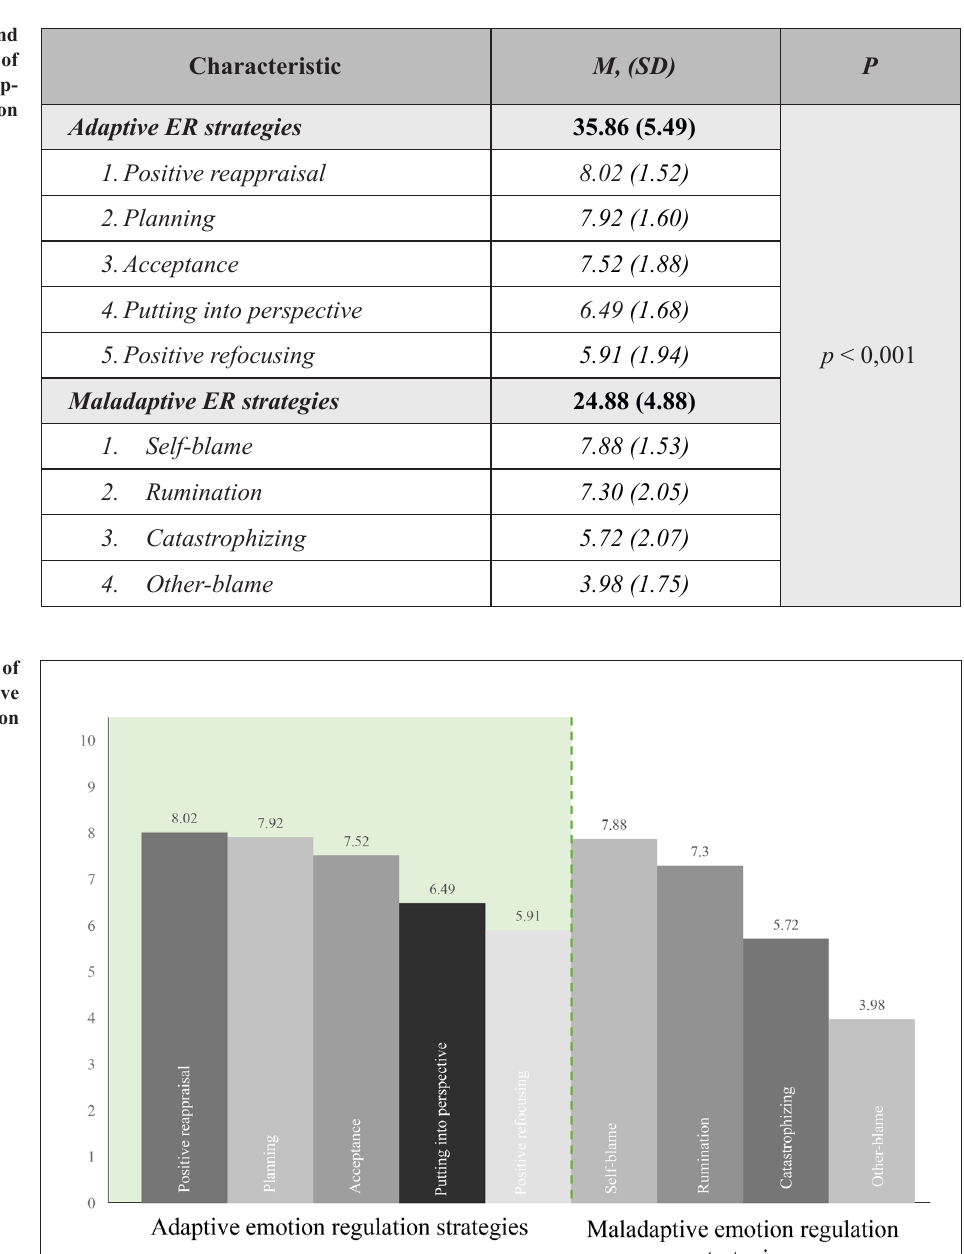
Figure 4. Means and Standard Deviations of Adaptive and Maladap-